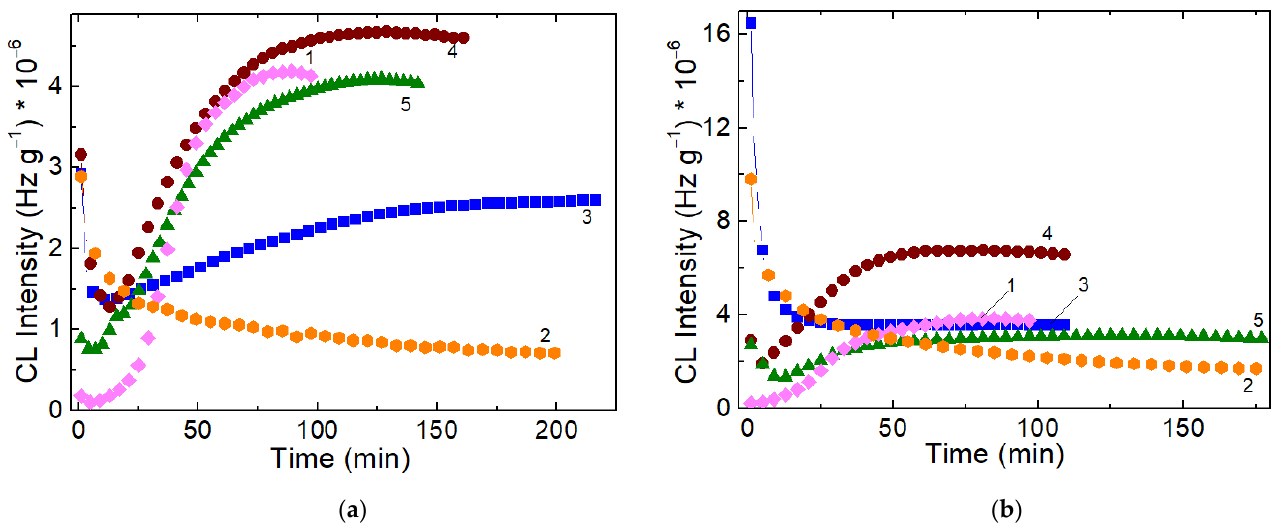
Figure 2. The isothermal CL spectra recorded on irradiated SIS/PCL samples at ( a ) 25 kGy and ( b ) 50 kGy. (1) neat SIS, (2) neat PCL, (3) SIS/PCL 1:3, (4) SIS/PCL 1:1; (5) SIS/PCL 3: 1. Testing temperature: 140 °C.